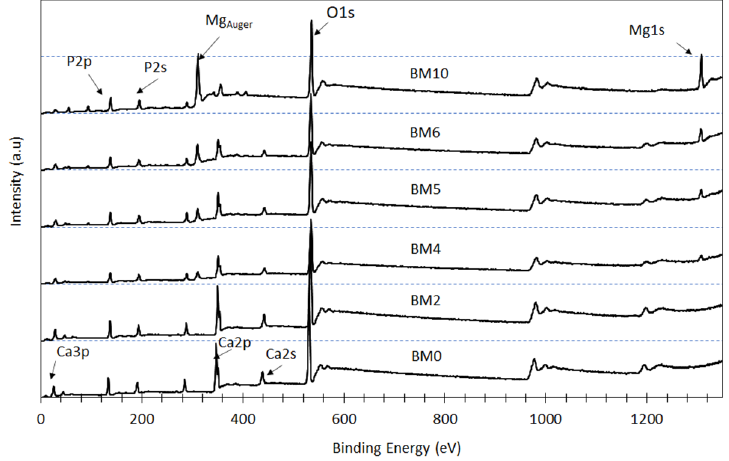
Figure 5. XPS spectra of Ca 1 − x Mg x · HPO 4 · nH 2 O